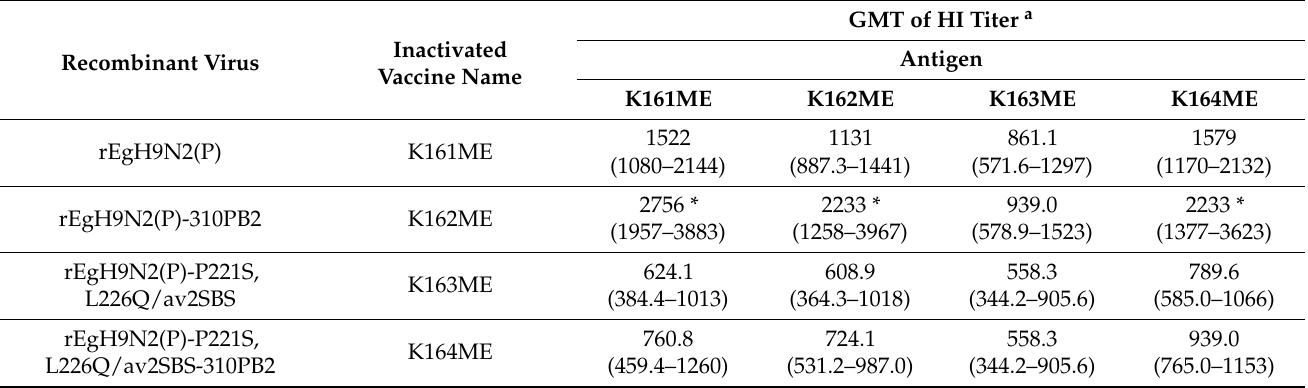
Figure 8. More efficient replication of PR8-derived recombinant Egyptian H9N2 strains than rPR8 and their attenuation by 01310 PB2 in mammalian cells. A total of 5 × 10 5 EID 50 (1 MOI) of each virus was inoculated into ( A ) MDCK and ( B ) A549 cells prepared in 12-well plates. After 1 h of incubation at 37 ◦ C, the cells were washed with PBS, and 1 mL of fresh medium was added to each well. During 72 h of incubation, supernatants were obtained at 24, 48, and 72 h, and viral titers in supernatants were measured in TCID 50 . * The amount of rPR8 was significantly lower than that of other recombinant H9N2 viruses ( p < 0.05). Table 5. Serum antibody titers of chickens vaccinated with inactivated oil emulsion of recombinant Egypt H9N2